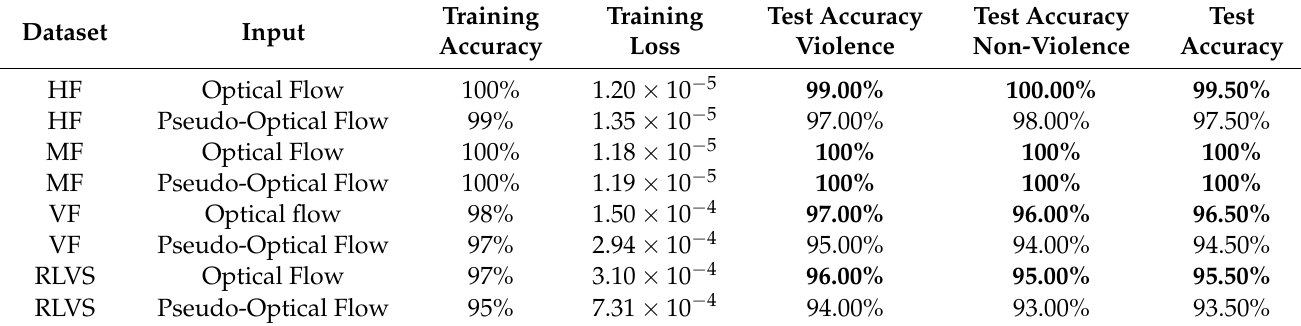
Table 3. Performance comparison for one iteration of our model for Hockey Fights, Movies Fights, Violent Flows and Real Life Violence Situations datasets.